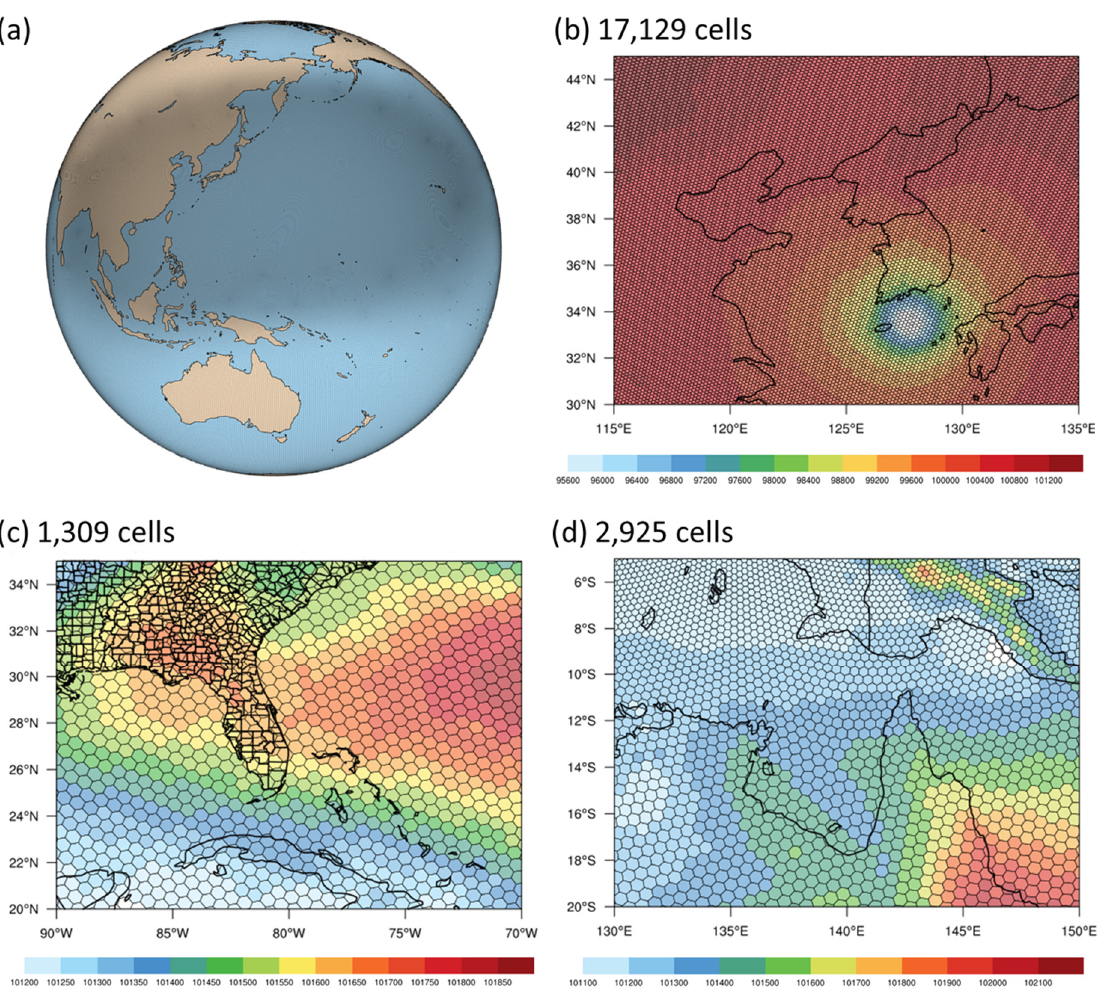
Figure 3. MPAS meshes used in this study: ( a ) global view of variable resolution (60–15 km), where the gray zone over East Asia and the northeast Pacific region has a finer resolution of 15 km; ( b ) high resolution meshes over Korea where there are 17,129 cells within the plot; ( c ) coarse resolution meshes over Florida where there are only 1309 cells in the plot; ( d ) transient resolution meshes over northern Australia where there are 2925 cells in the plot. Shadings of ( b – d ) indicate the 36 h forecast of mean sea-level pressure valid at 12UTC on 2 September 2020.